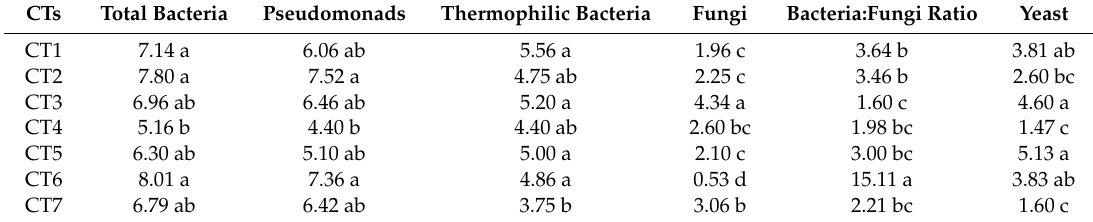
Table 2. Results of microbiological characterization of compost teas (CTs) used in this study. Data are expressed as log CFU mL − 1 . Di ff erent letters indicate significant di ff erences among means according Tukey’s HSD test at p ≤